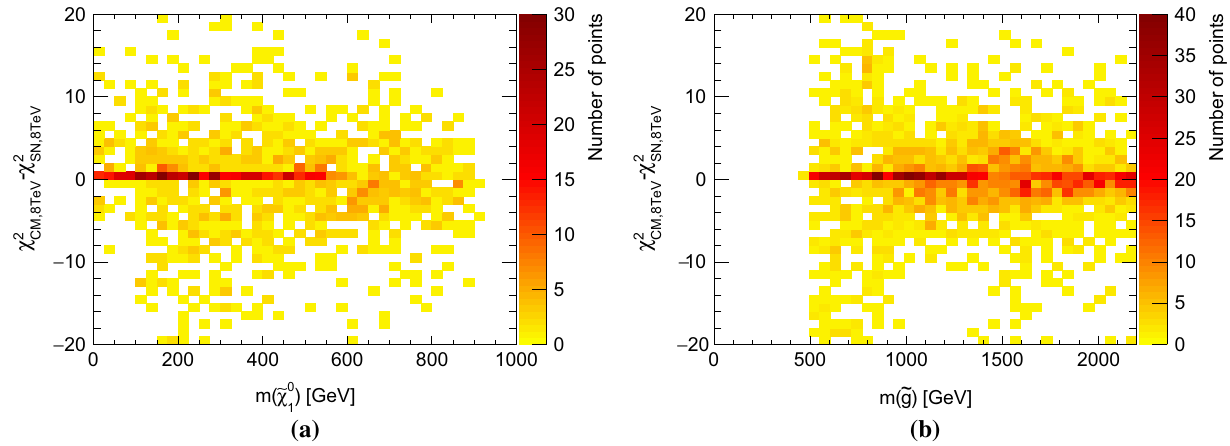
Fig. 10 Using validation points from Fig. 9, we show the difference between the SCYNet parametrization and the CheckMATE result against ) for gluino masses between 850 and 900 GeV ( a ) and against m ( ˜ g ) for neutralino masses between 400 and 450 GeV ( b ) m ( ˜ χ 0 1